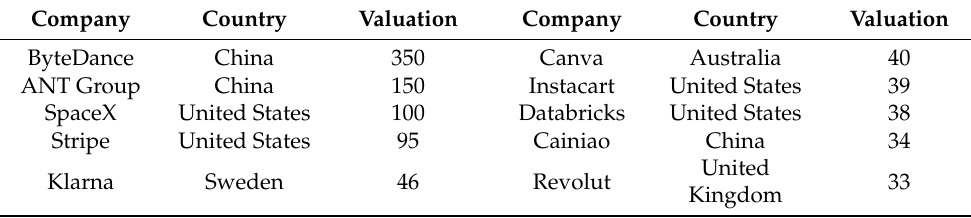
Table 3. Leading top 10 unicorns worldwide as of 2021 (in billion